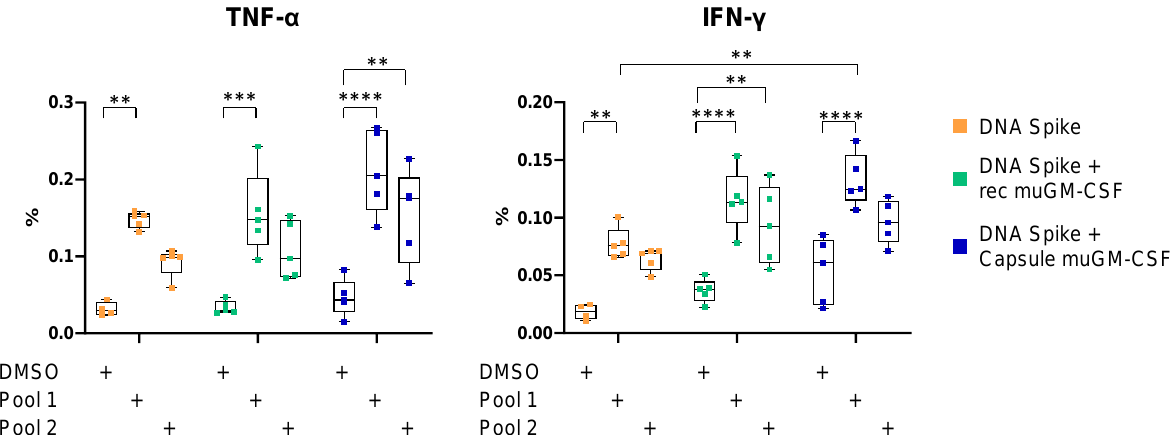
Figure 2. TNF- α and IFN- γ production by CD8+ T cells 10 days after vaccination. Mice were immunized with a single dose of spike DNA plasmid with or without GM-CSF (recombinant or secreted by encapsulated cells) as an adjuvant. T cells response was measured at Day 10 by intracellular cytokine staining (ICS) after stimulation of splenocytes with spike protein peptide pools or DMSO as a negative control. Data show the percentage of TNF- α or IFN- γ -secreting CD8+ T cells after stimulation. Data are represented as min-to-max boxes with individual values. ** p < 0.01, *** p < 0.001, and **** p <